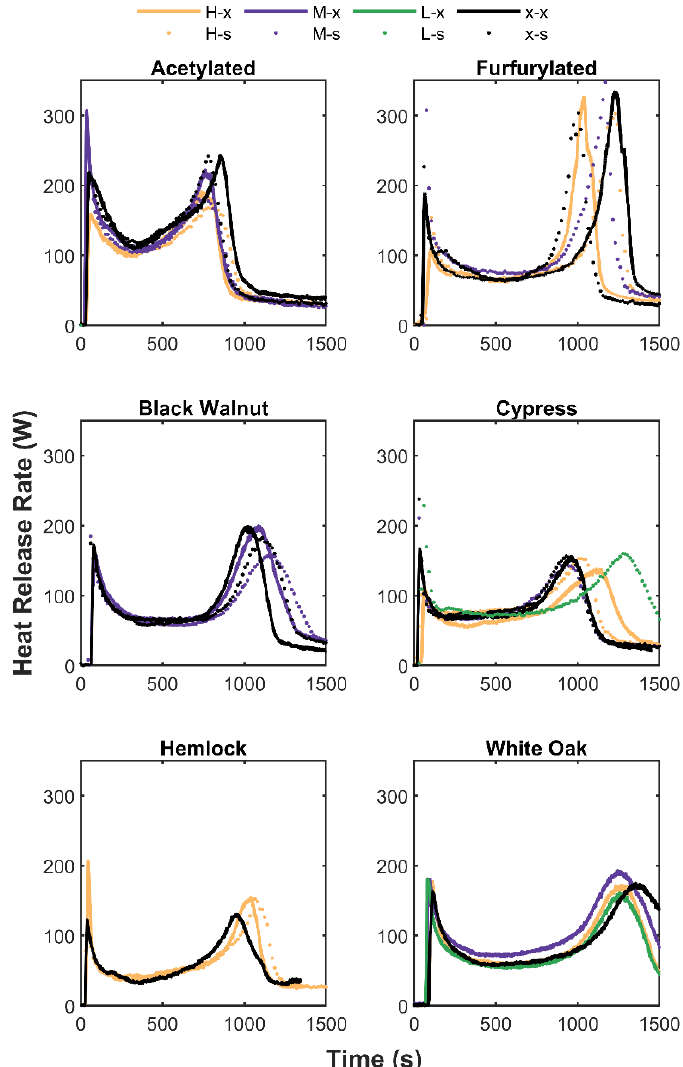
Figure 3. Average heat release rate curves for each